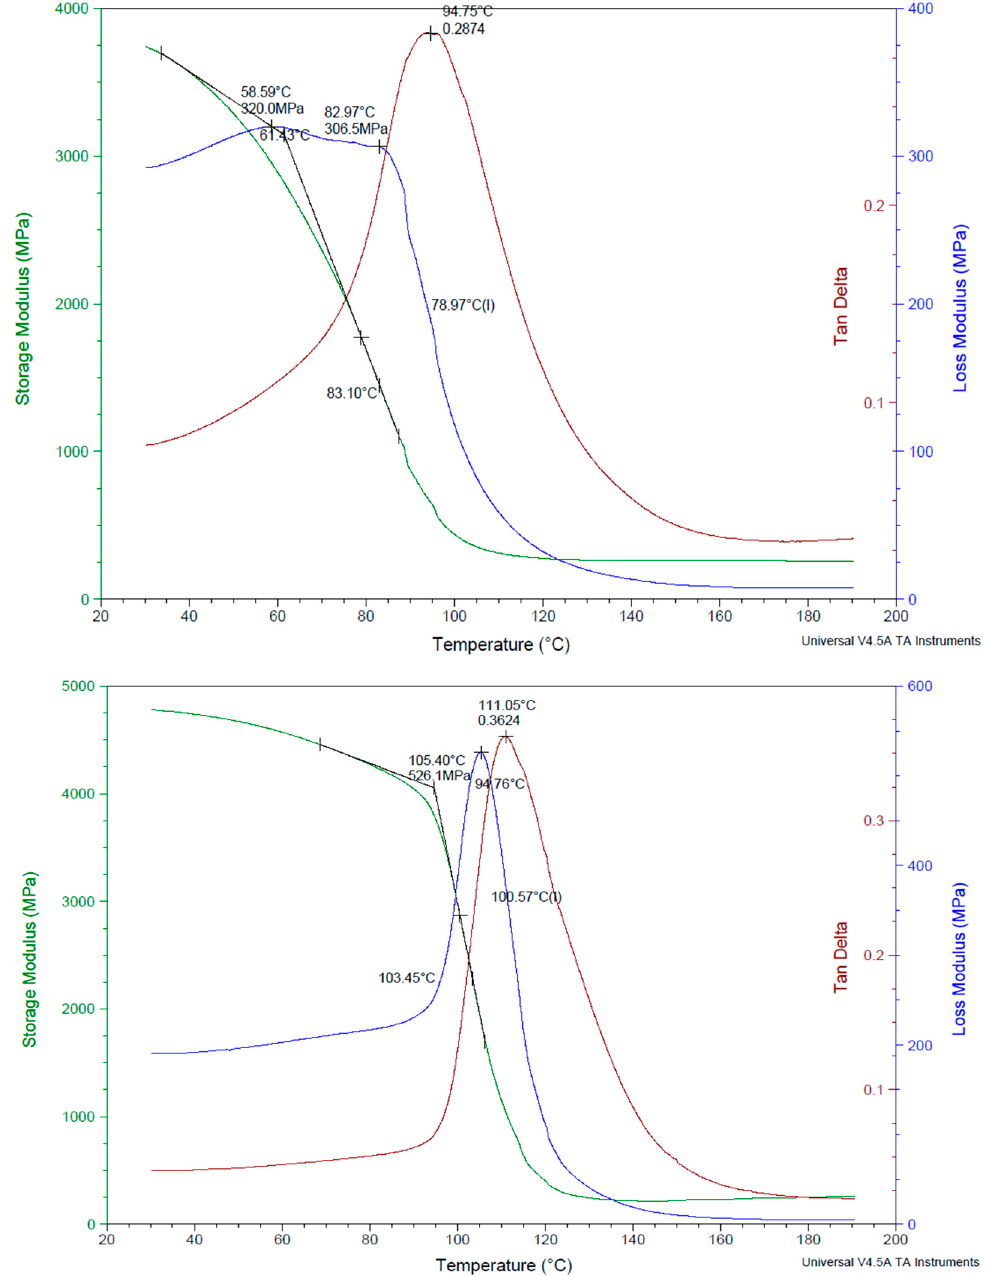
Figure 10. DMA properties of S3 with 15 wt% and without SiC composite laminates.